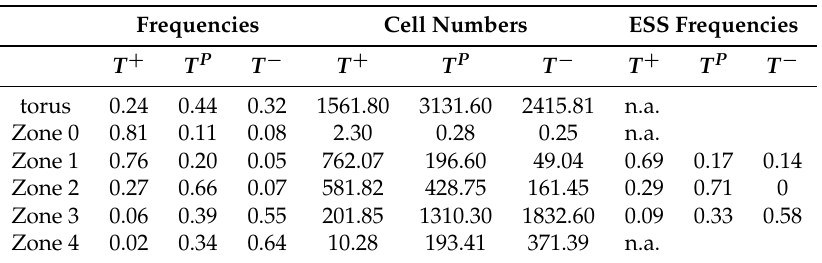
Table 2. Mean frequencies and population sizes of the three cell types averaged over the last 1000 generations. The final three columns provide the non-spatial ESS frequencies for the three zones. Results are from a single run where neighborless cells cannot proliferate: σ = 0. Replicate runs provide very similar outcomes.